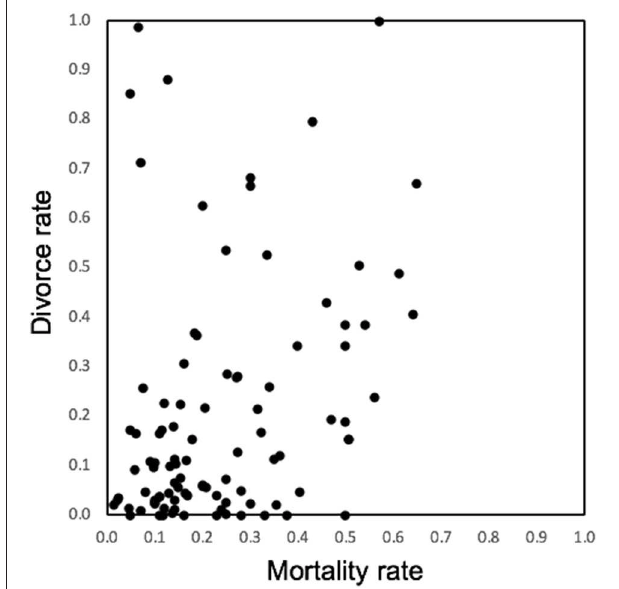
FIGURE 2 | Variation in the rate of mortality and divorce for the 97 species of bird in which both parameters were reported in the supplementary table provided in Jeschke and Kokko (2008). The mortality rate is the proportion of adults that die between 1 year and the next, divorce is the proportion of pairs that are made up of individuals breeding with a new partner when both former partners are still alive (full details and original sources given in Jeschke and Kokko, 2008